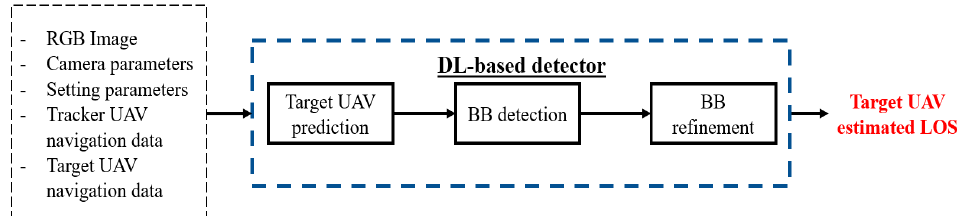
Figure 2. Scheme summarizing the algorithmic strategy characterizing the proposed DL-based detector. The input parameters are listed within a black (dashed) rectangular box. The processing blocks are enclosed within black rectangular boxes. The final output is highlighted in red.